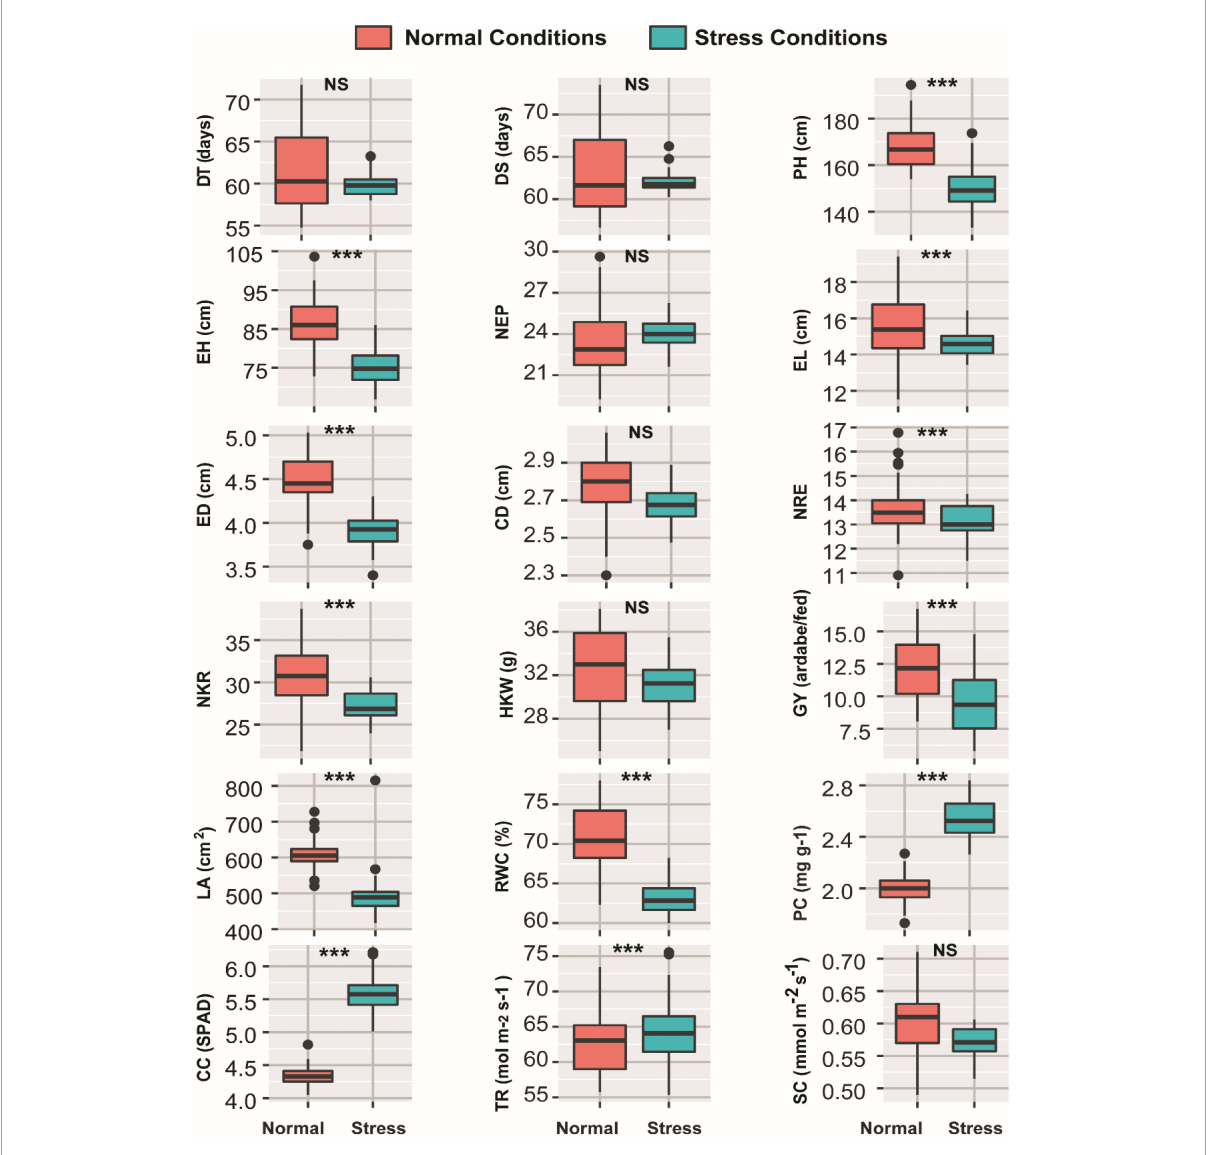
FIGURE1 Boxplots showing variation in all 18 morpho-physiological and biochemical measured traits of 45 maize inbred lines grown under normal and drought conditions. *** and NS denote significant variation between treatments at 0.1% levels of probability and non-significant, respectively. DT, days to 50% tasseling; DS, days to 50% silking; PH, plant height (cm); EH, ear height (cm); NEP, no. of ears/plant; EL, ear length (cm); ED, ear diameter (cm); CD, cob diameter (cm); NRE, no. of row/ear; HKW, 100-kernel weight (g); NKR, number of kernel/row; GY, grain yield (ardbe/fed); LA, leaf area (cm 2 ); RWC, relative water content (%); PC, proline content (mg g – 1 ); CC, chlorophyll content (SPAD); TR, transpiration rate (mmol m – 2 s – 1 ); SC, stomatal conductance (mol m – 2 s – 1